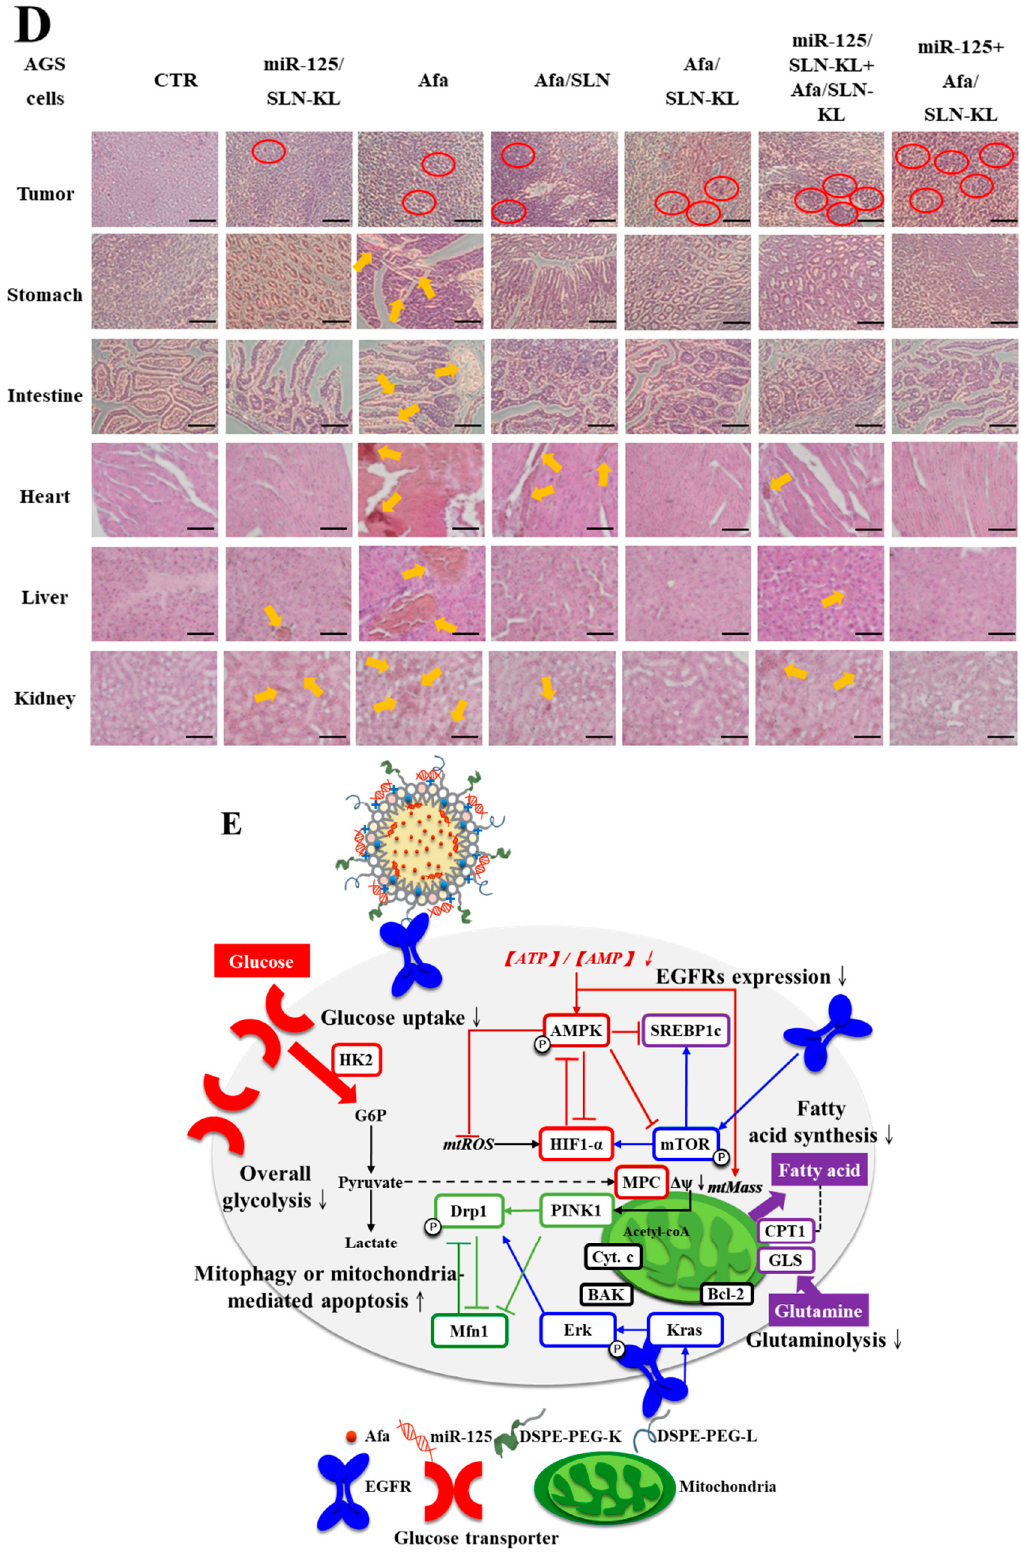
Figure 8. Biosafety and biodistribution studies of various formulations of Afa (5 mg/kg) and/or miR- 125 (1.25 mg/kg) in AGS-bearing mice. ( A ) Measurement of body weight of AGS-bearing mice every 4 days after treatment with various formulations for 14 days. ( B ) Biodistribution study of different formulations after completion of 14-day therapy. ( C ) Blood biochemical indices of glucose (GLU), cholesterol (CHO), and triglycerides (TGs) and functions of liver by glutamic pyruvic transaminase (GPT), kidney by blood urea nitrogen (BUN), and heart by creatine kinase-MB (CK-MB) after